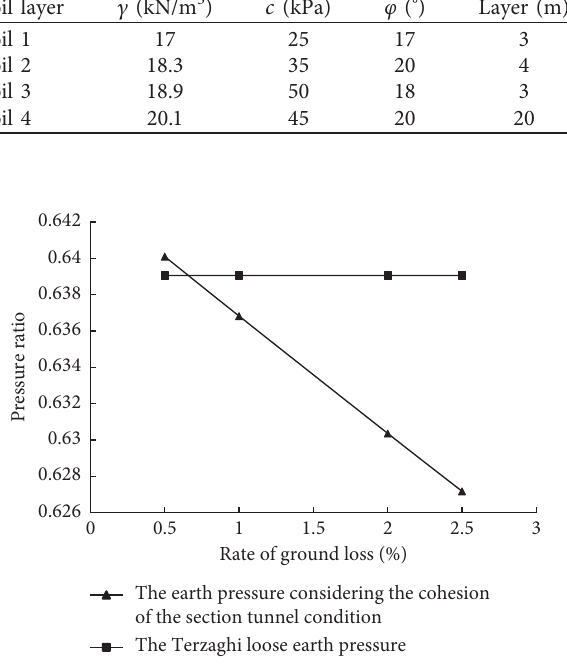
Figure 2: The pressure ratio in different strata loss